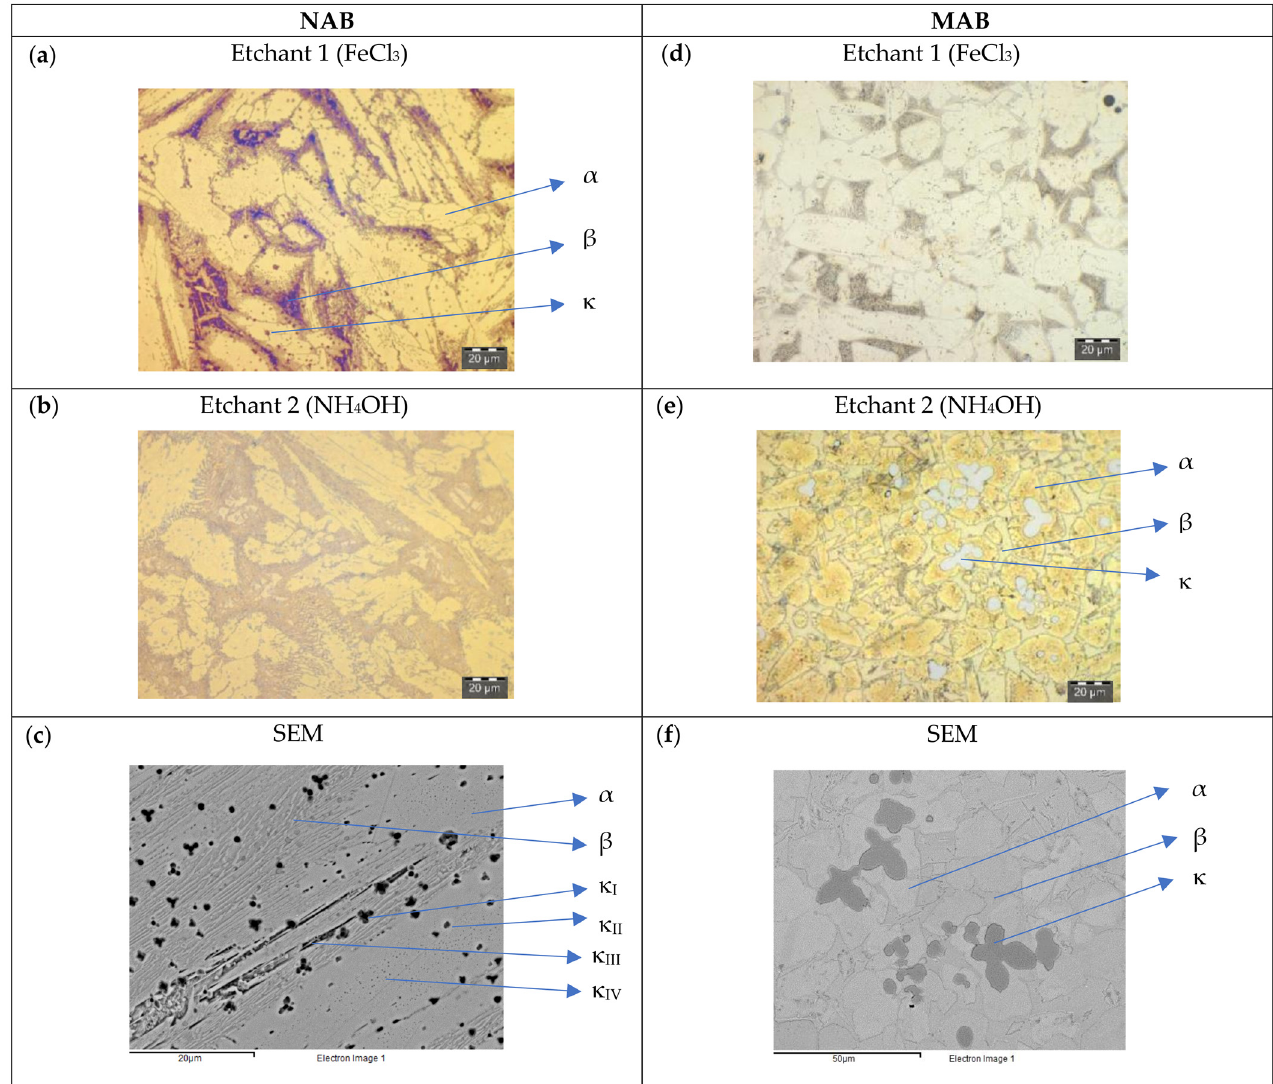
Figure 4. As-received (AR) NAB and MAB microstructure. LOM images after applying etchants 1 ( a , d ) and 2 ( b , e ), and SEM-BSE pictures ( c , f ).